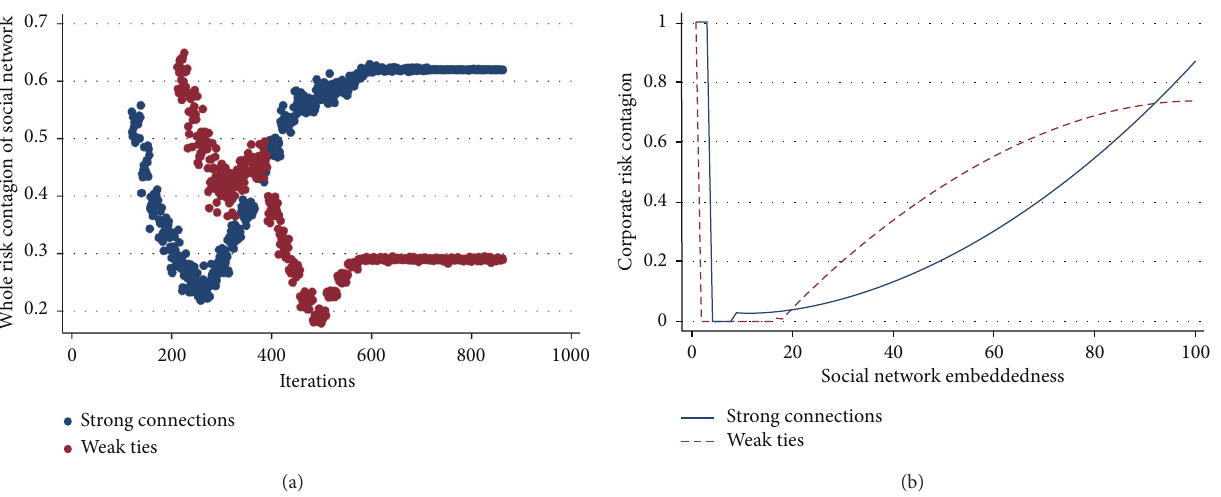
Figure 3: Social networks and risk contagion process. (a) Whole risk contagion over time. (b) Risk contagion and social network embeddedness.